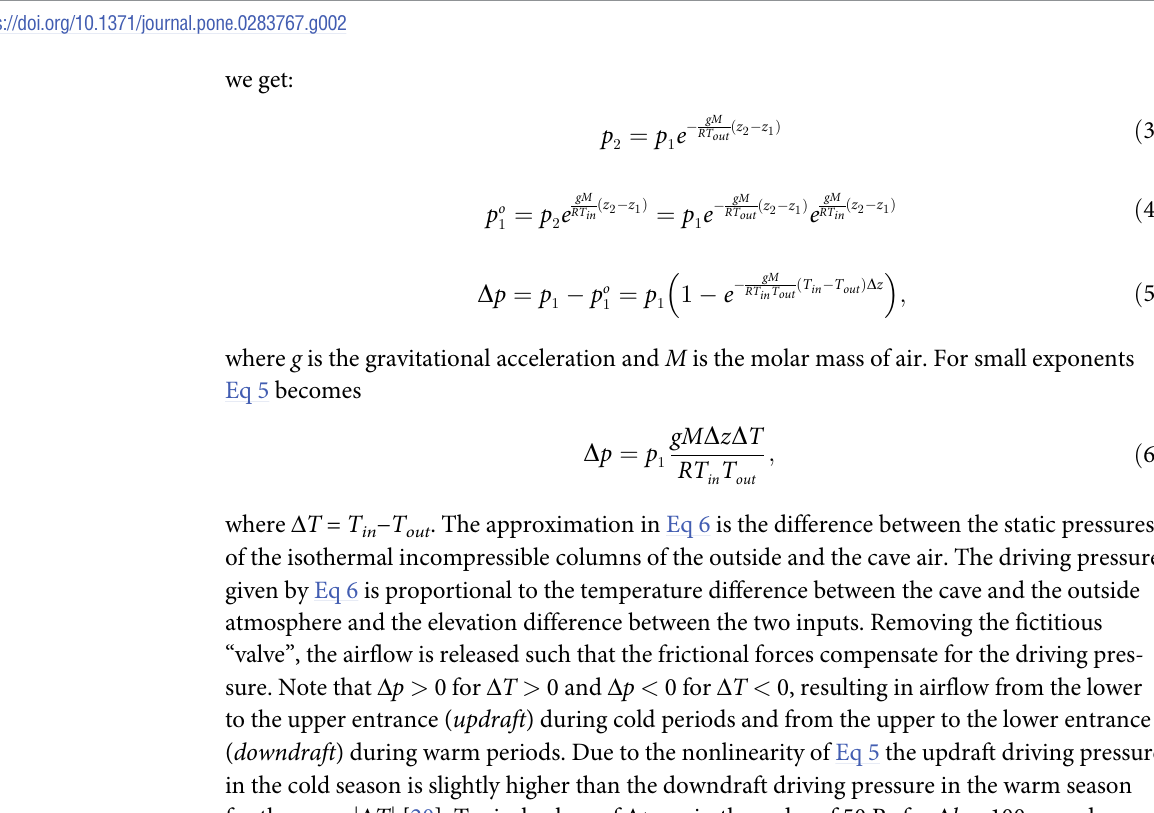
Fig 2. Variation of air density with temperature for different values of CO 2 and relative humidity (RH). Insert shows the concept of the virtual temperature: air with T = 21.5˚C, RH = 0 and p